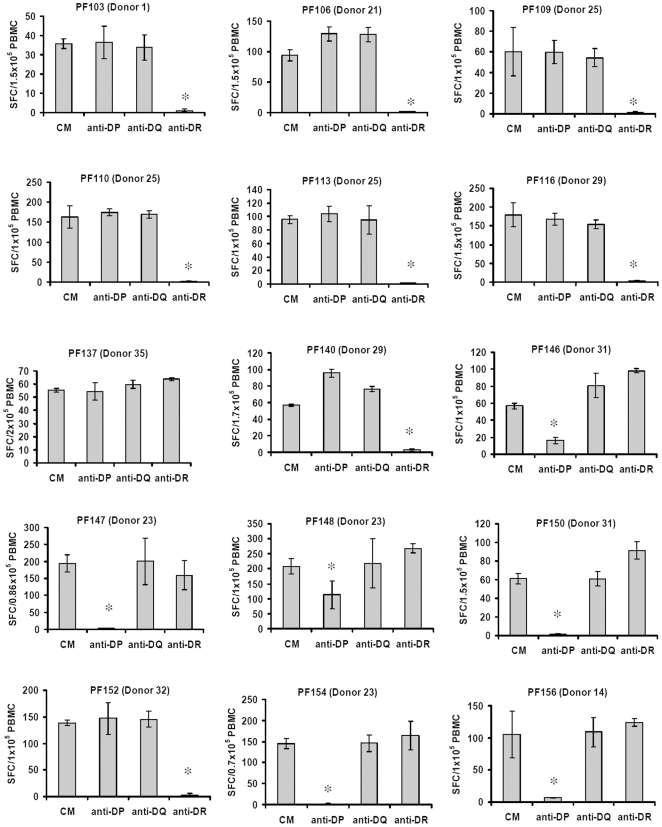
Flu-derived 9mer peptides induce HLA-DR- or -DP restricted CD4+ T cell responses.PBMCs from responding donors were incubated with the indicated peptides for 10 days. Prior to testing, cells were harvested, washed and exposed to the peptides in ELISPOT plates for 20 h in the absence or presence of anti-HLA-DP, DQ or DR mAbs. Results are expressed as the mean SFC numbers (± standard deviation) of four replicate ELISPOT microcultures. Bars represent standard deviation; *significant inhibition, P<0.05 (Student's t- test).